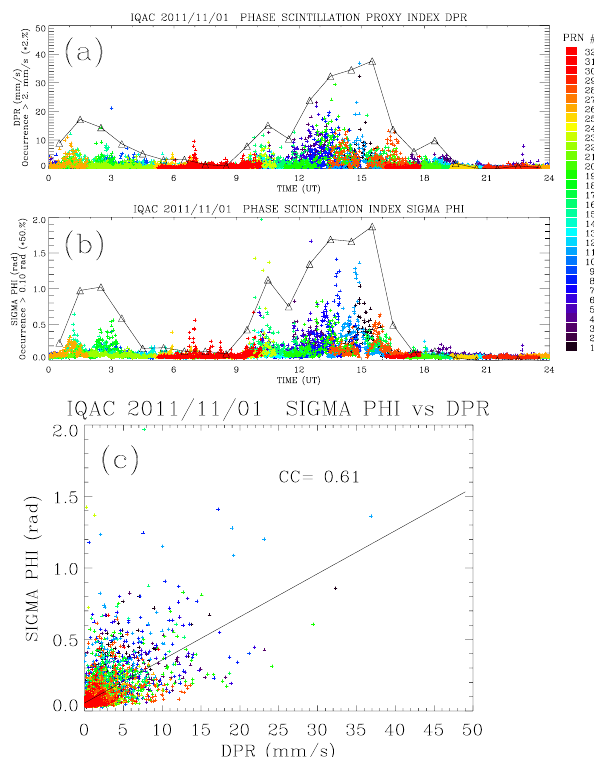
Fig. 10. (a) The proxy DPR index and (b) the 60-s phase scintilla- tion σ 8 for Iqaluit on 1 November 2011. The hourly percentage occurrence of both indices exceeding given threshold values are shown by triangles using a scale with a maximum of 100% as in- dicated by scale factors. (c) Scatter plot σ 8 versus DPR showing a moderate correlation between the two